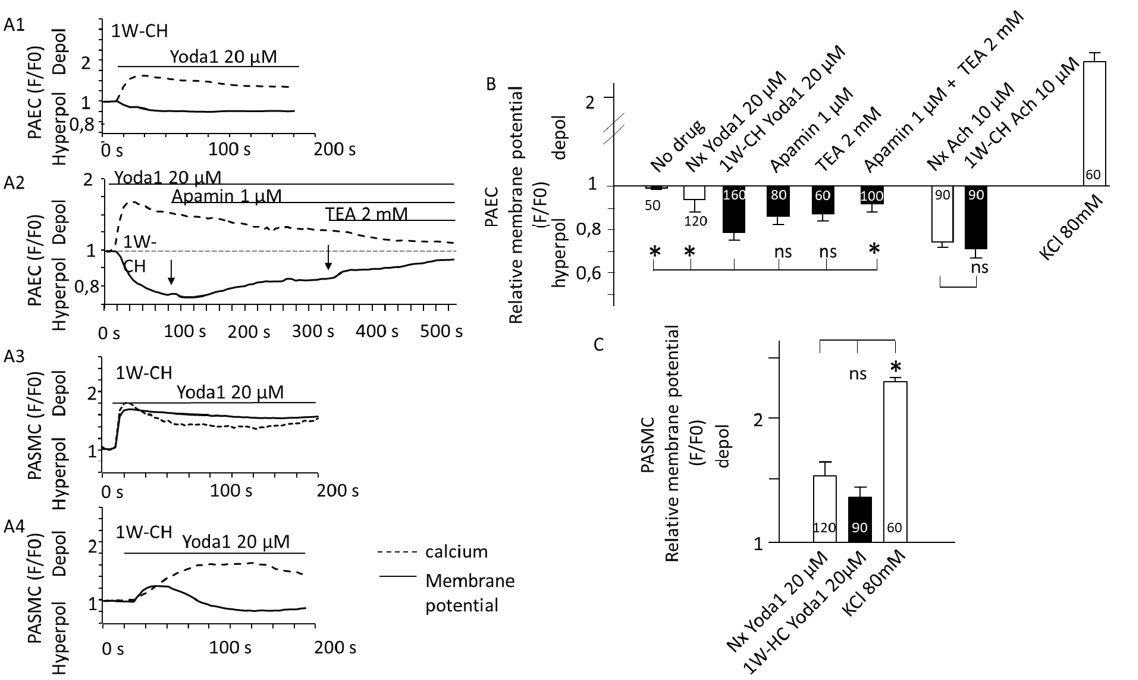
Figure 7. Yoda1 induced hyperpolarization of the transmembrane potential in PAECs. Piezo1 activation changed transmembrane potential. ( A ) Typical traces of the FLIPR fluorescence were recorded in freshly isolated vascular cells stimulated with Yoda1 (20 µ M) (black line). Dash lines represent [Ca 2+ ]i increase recorded simultaneously with the Cal520 fluorescent probe. Yoda1 ( A1 ) hyperpolarized PAECs. This hyperpolarization was reduced by the application of apamin (1 mM), then apamin plus TEA (2 mM), and inhibitors of calcium-dependent potassium channels ( A2 ). By contrast, Yoda1 depolarized PASMCs ( A3 ) or could sometimes have a biphasic response ( A4 ). ( B ) Statistical analysis of the membrane potential variation induced by Yoda1 (20 µ M) in freshly isolated PAECs from Nx and 1W-CH IPA. The decrease in FLIRP fluorescence in the presence of Yoda1 was reversed by the combination of apamin (1 µ M) plus TEA (2 mM). ( C ) Statistical analysis of the membrane potential variation induced by Yoda1 (20 µ M) in freshly isolated PASMCs from Nx and 1W-CH IPA. As the control, KCl solution (80 mM) was applied to measure strong depolarization. For statistical analysis, antagonists (apamin and TEA) were preincubated before Yoda1 application and not after, as for Figure 2A. * p < 0.05. n represented the number of analyzed cells, five different rats at 3.7. Yoda1 Induces Signaling Pathways Leading to eNOS Activation via Akt Signal pathways in